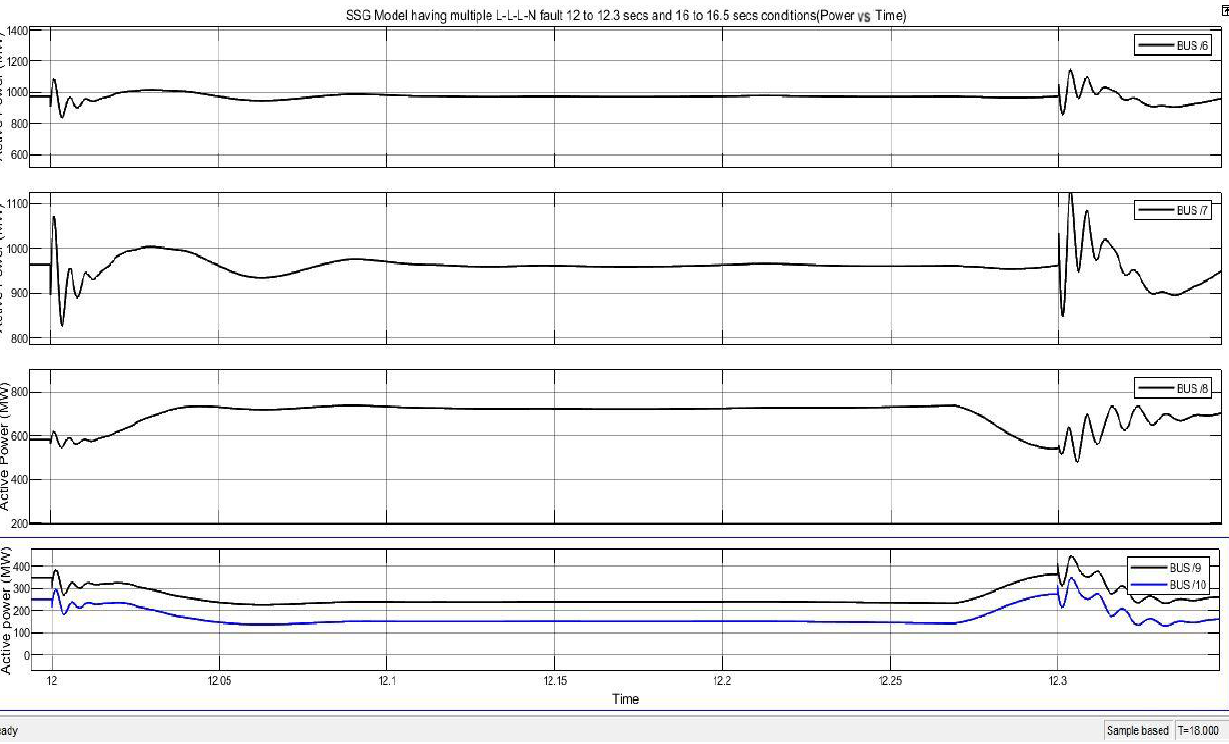
Figure 33. Multiple line-to-line (L-L-L-N) faults are inserted in the system from 12 to 12.3s (Bus 6 to Bus 10).